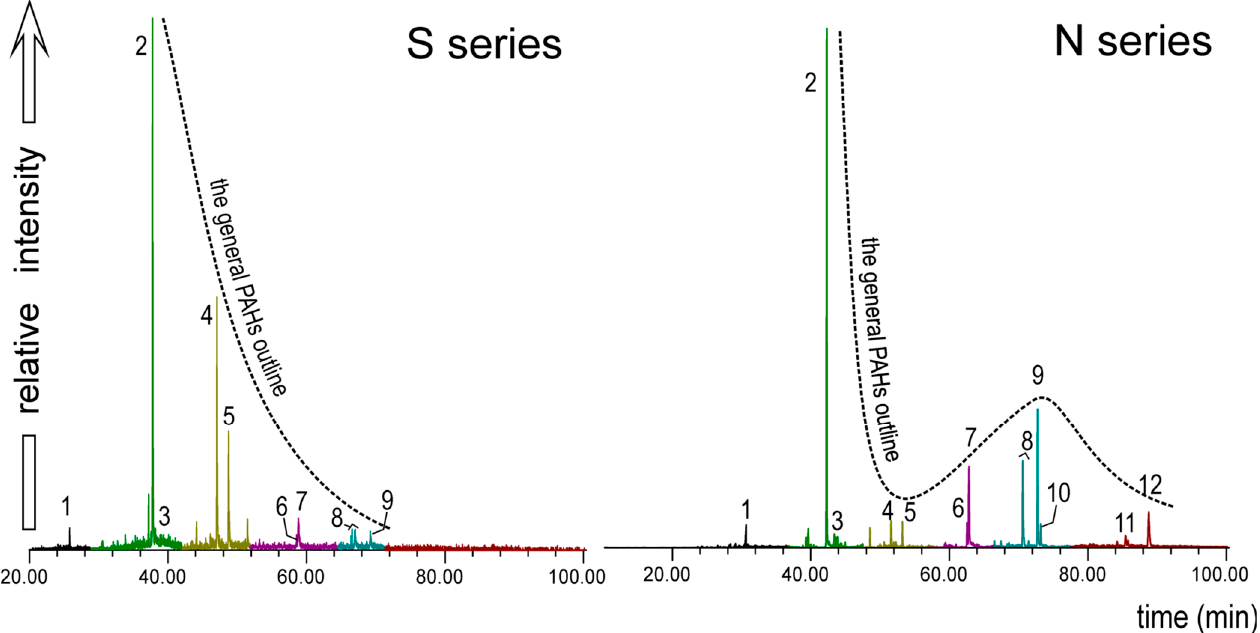
Figure 14. Two types of polycyclic aromatic hydrocarbons distributions. Peaks identification: 1: naphthalene, 2: phenanthrene, 3: anthracene, 4: fluoranthene, 5: pyrene, 6: benzo(a)anthracene, 7: chrysene, 8: benzofluoranthenes, 9: benzo(a)pyrene, 10: benzo(e)pyrene, 11: benzo(ghi)perylene, and 12: